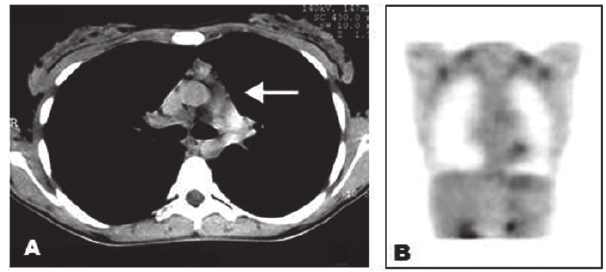
Figure 2 - Residual mass evaluated by CGC-PET with FDG. Panel A – Thoracic CT with evidence of residual mass on mediastinal area (white arrow) observed after the treatment in a 32-year-old female. Panel B – CGC-PET (coronal plane) of the same patient without any foci of abnormal glucose metabolism in the mediastinal